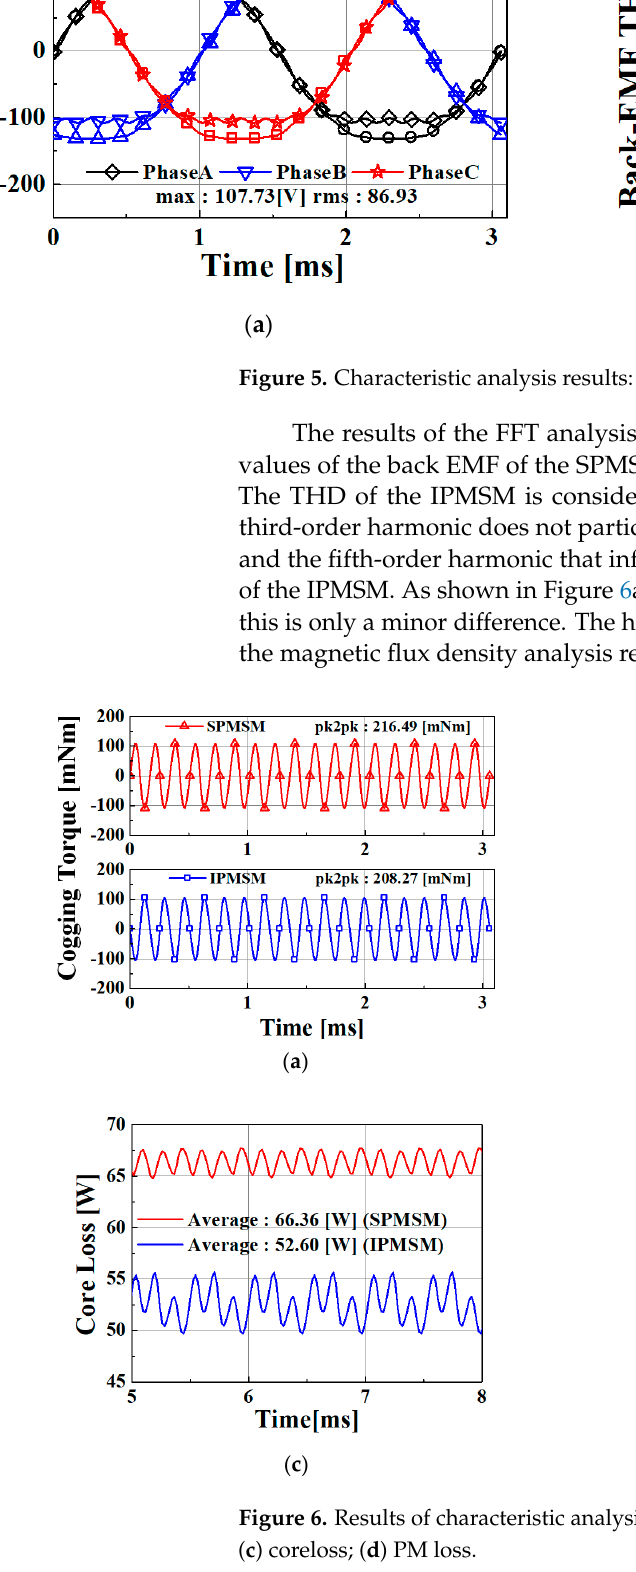
Figure 6. Results of characteristic analysis: ( a ) cogging torque; ( b ) torque ripple . loss analysis results: ( c ) coreloss; ( d ) PM loss .